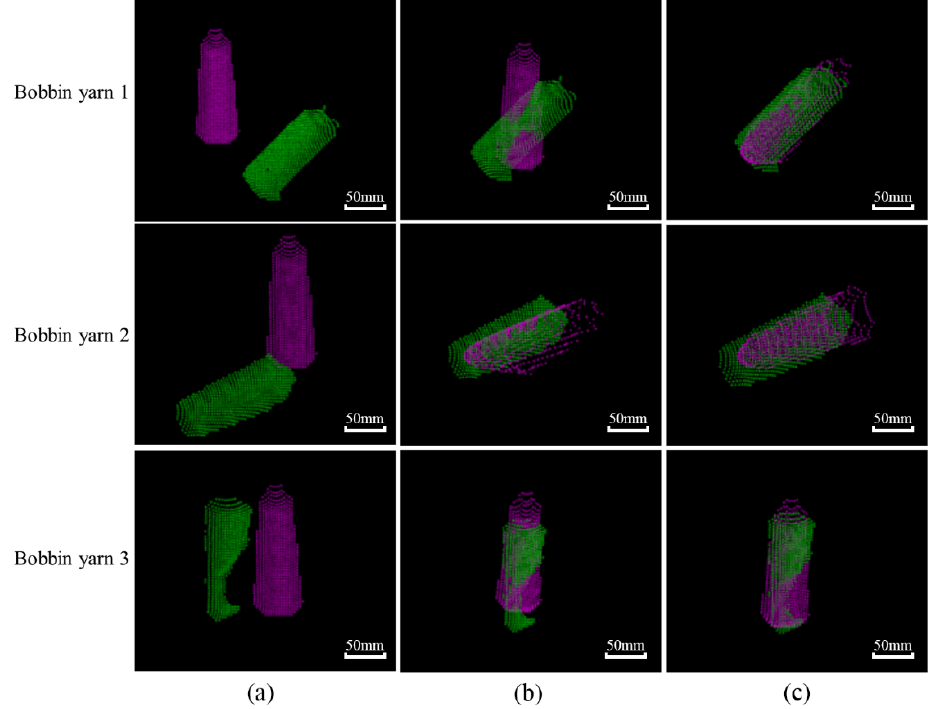
Figure 7. Point cloud alignment results: ( a ) initial position; ( b ) coarse alignment; ( c ) fine alignment.